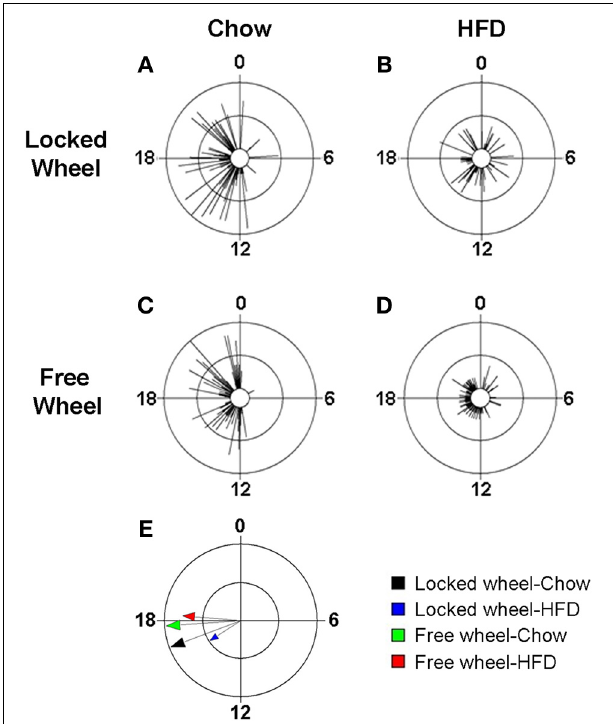
FIGURE 5 | Wheel-running activity alters the eating behavior rhythm in mice fed high-fat diet. Male wild-type mice were single-housed in 12L: 12D with a locked (A,B) or freely rotating (C,D) running wheels at 7 weeks old. Chow was provided ad libitum for 1 week (Days 1–7) and then chow was replaced with high-fat diet (HFD) for 1 week (Days 8–15). Representative circular histograms ( A–D ; plotted in 10-min bins; scale: inner circle, 0; middle circle, 5.5, outer circle, 11; units: eating events per 10-min bin) show the distribution of eating events for a mouse during chow (Day 7; left panels) and HFD (Day 9; right panels) consumption relative to the time of day (where 0 is lights on and 12 is lights off). Grand mean vectors of eating behavior ( E ; n = 5 mice/group) during chow (black and green arrows) or HFD (blue and red arrows) feeding in mice with locked (black and blue arrows) or freely-rotating wheels are plotted on the circular histogram (plotted in 10-min bins; scale: inner circle, 0.3; outer circle, 0.6). The size and length of the arrow represents the uniformity of the distribution of the eating events where small, short arrows indicate that eating events are more evenly distributed across the